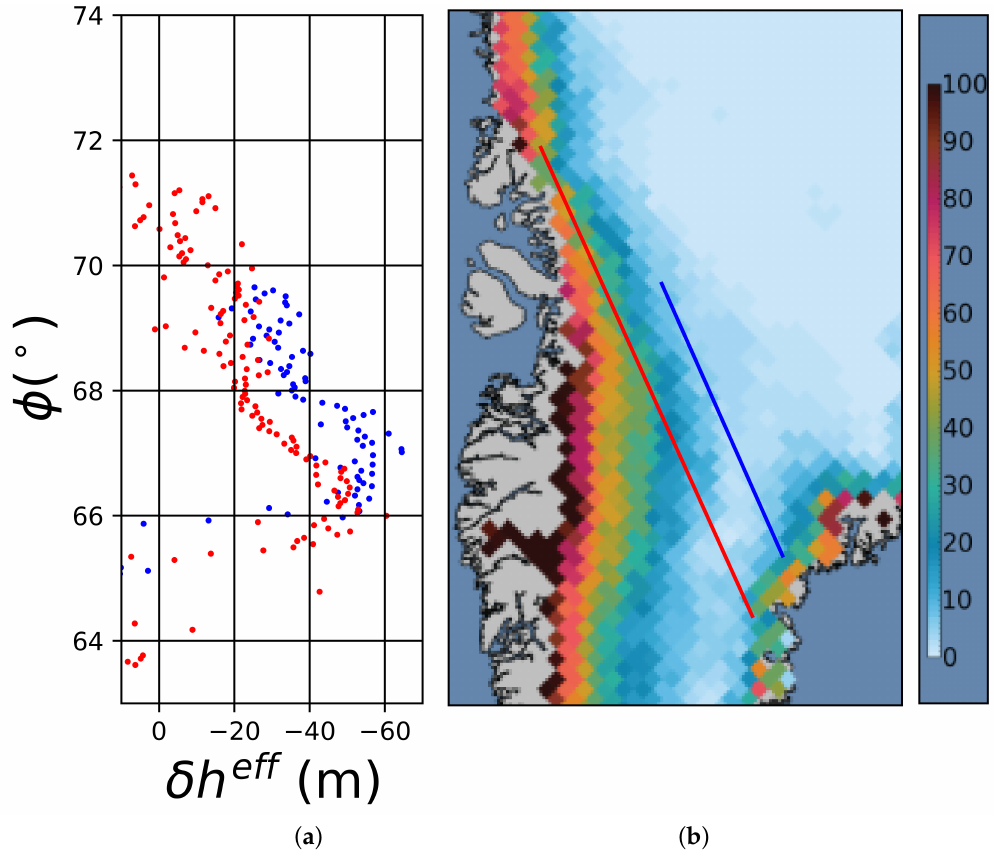
Figure 9. ( a ) Estimates of δ h eff as a function of the latitude of the specular point for the 26 January 2015 track (blue), and the 27 January 2015 (red). ( b ) Section of the Greenland Map, courtesy of University of Georgia/Thomas Mote, supplied by the National Snow and Ice Data Center, University of Colorado, showing the number of melting days [48], indicated by the color scale, for the period January–October 2016. The two traces correspond to the approximate location of the specular points